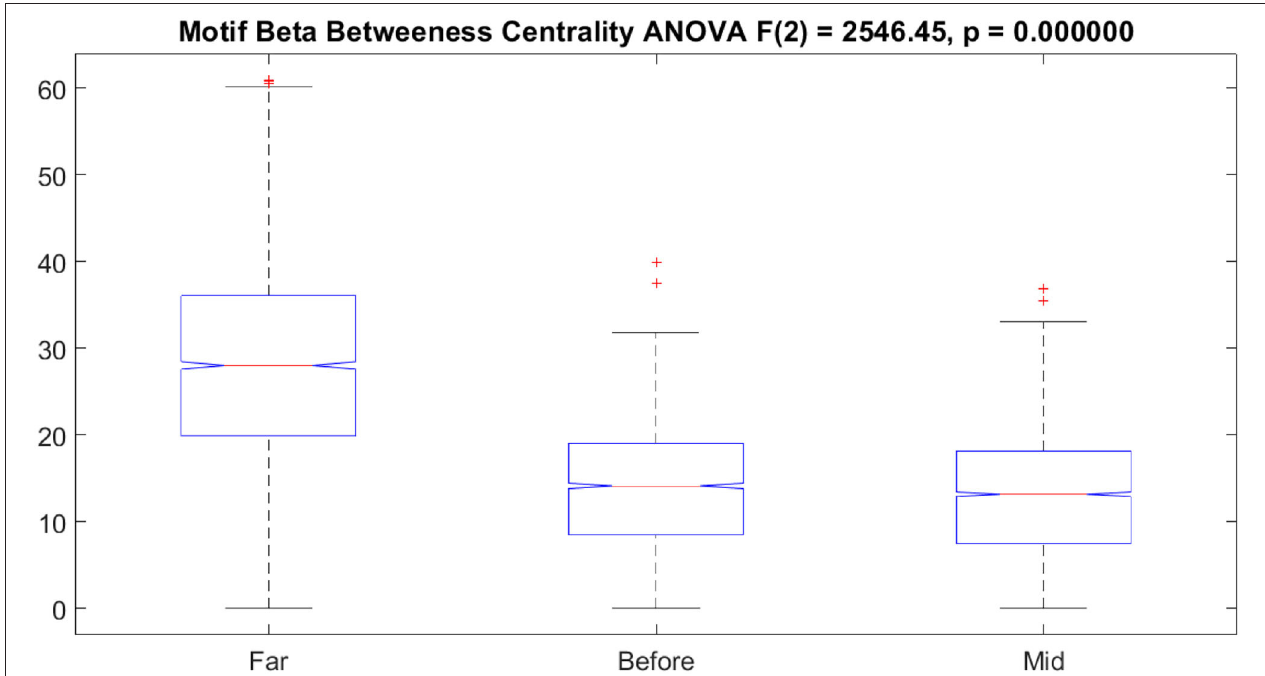
FIGURE 9 | Boxplot for global betweenness centrality obtained with the motif method applied to the beta band and corresponding ANOVA result, comparing distributions obtained from far, before, and mid 1s EEG segments.